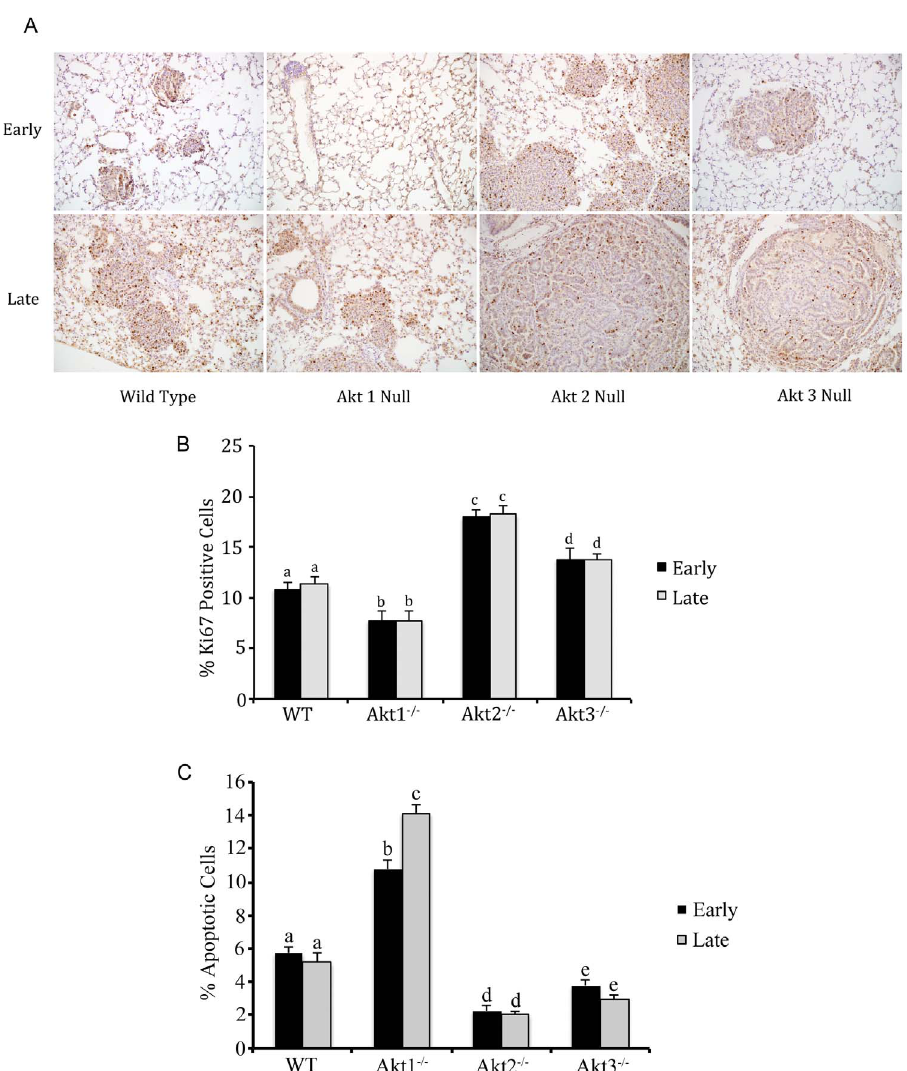
Figure 5. Akt1 ablation inhibits cell proliferation and promotes apoptosis of lung epithelia in A JE JJenv infected mice. (A) Lung tissue sections from WT, Akt1 2 / 2 and Akt3 2 / 2 mice at 12 (early) and 32 (late) weeks post-infection and Akt2 2 / 2 mice at 12 (early) and 20 (late) weeks post- infection stained with an antibody against the proliferation marker Ki67. (B) Graphical representation of the number of Ki67 positive cells. The number of Ki67-positive (proliferating) cells was measured in sections of lung derived from three randomly selected mice of each genotype and three randomly selected fields per mouse. The bars show the mean percentage of proliferating cells 6 SE of the mean for each genotype. (C) Quantification of TUNEL-positive apoptotic cells in early and late (advanced) neoplastic lesions from WT, Akt1 2 / 2 , Akt2 2 / 2 and Akt3 2 / 2 A JE JJenv infected mice. The number of TUNEL-positive cells was measured in sections of lung derived from three randomly selected mice of each genotype and three randomly selected fields per mouse. The bars show the mean percentage 6 the SE of the mean of TUNEL-positive cells in early and late lesions. For figures B and C, 2-way ANOVA and Bonferonni’s correction was used and bars on the graph with different letters are statistically different (p , 0.05). doi:10.1371/journal.pone.0094595.g005 FoxO3a and BAD, leading to their inactivation and promotion of cell survival [28–30]. We observed an increase in FoxO3a phosphorylation in WT and Akt1 2 / 2 mice concomitant with tumor burden (Figure 6M, panels 1 and 2), but FoxO3a phosphorylation remained constant in Akt2 and Akt3 mice irrespective of tumor burden (Figure 6M, panels 3 and 4). Despite many attempts, we were unable to detect phosphorylated BAD (data not shown). Lastly, as expected, ablation of Akt isoforms had no effect on Erk1/2 activation as phospho-Erk1/2 increased over time in all three knockout mice as well as in the WT mice (Figure 6N). In summary, Akt isoform ablation predominantly influences GSK-3 a / b and mTOR signaling in this model.